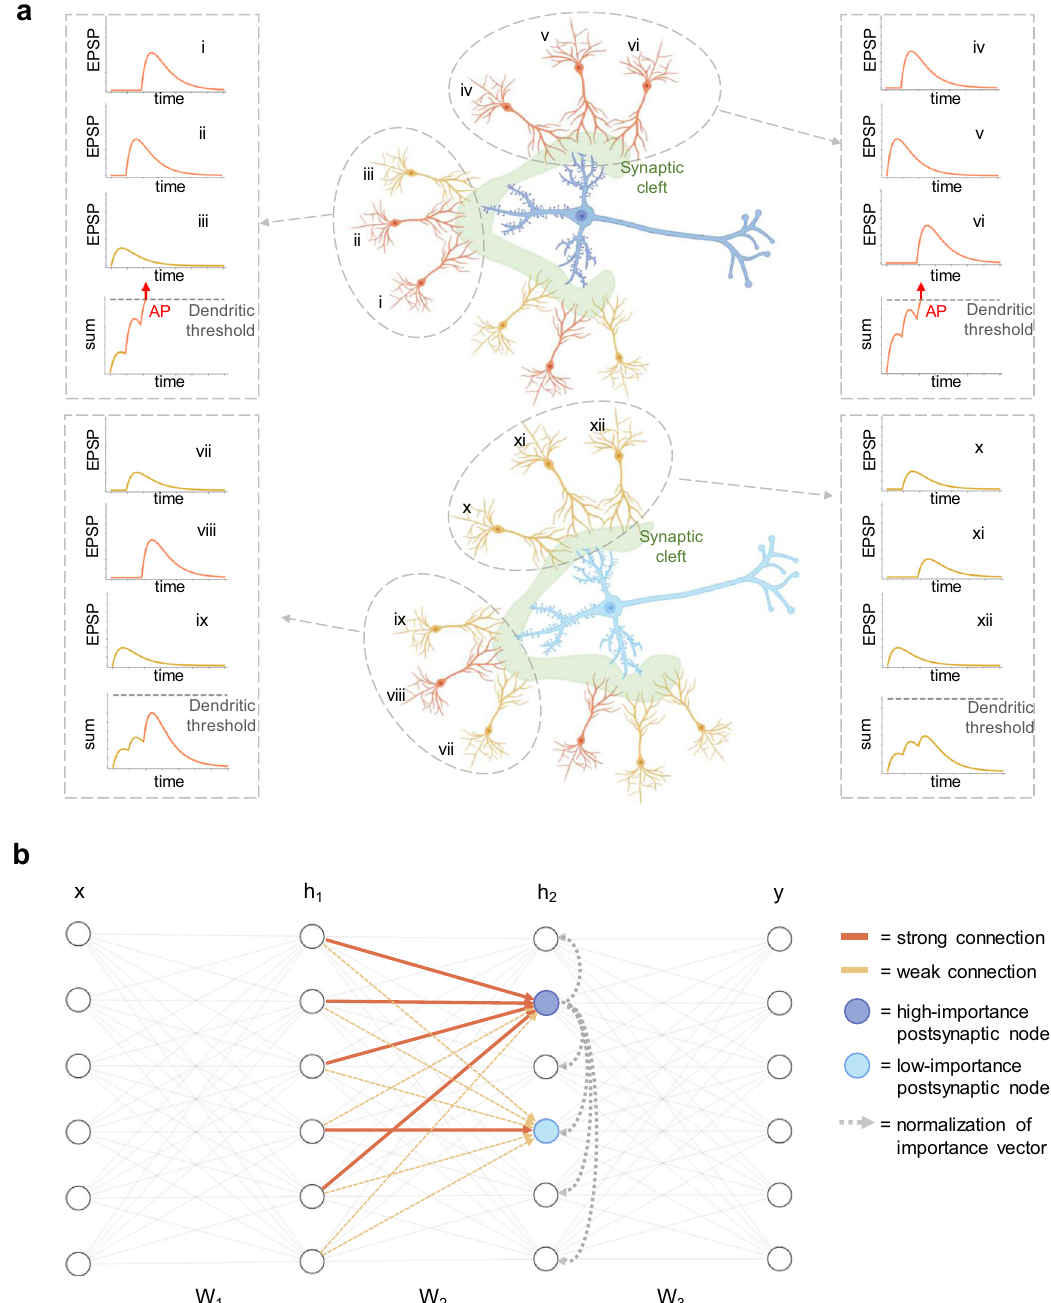
Fig. 1 Synaptic strength distribution in biological and arti fi cial networks. a In biological synapses, during the process of synaptic integration, dendritic spikes can enhance the impact of synchronous inputs from dendrites belonging to the same tree. Excitatory postsynaptic potentials (EPSPs) with the same amplitude but different locations in a dendritic tree may lead to different responses. For example, dendrites i , iv, and viii send similar signals, but only the i and iv contribute in driving an AP, since their respective branches receive suf fi cient further excitation from other connected dendrites. In the top image, the postsynaptic neuron (dark blue) receives inputs mostly from dendrites generating strong EPSPs (orange) and only few generating weak EPSPs (yellow). The bottom postsynaptic neuron (light blue) receives most inputs from weak-EPSPs dendrites. Because of such a dendritic distribution, the dark blue neuron exhibits higher fi ring probability and thus its importance is higher with respect to the light blue neuron. b The structure of an FCNN is much simpler than that of biological neurons with presynaptic connections arranged in dendritic trees. However, analogously to panel ( a ), the node importance of each node arises from the distribution of the weight strength within each layer. The blue node has a high node importance since most of its incoming synapses are strong. Conversely, the light blue node ’ s importance is lower, since the presynaptic population exhibits a weaker mean strength. The gray dotted lines emanating from the neuron with the highest importance and arriving at the other nodes in the same layer represent a normalization effect, resembling the winner-take-all competition based on the highest importance